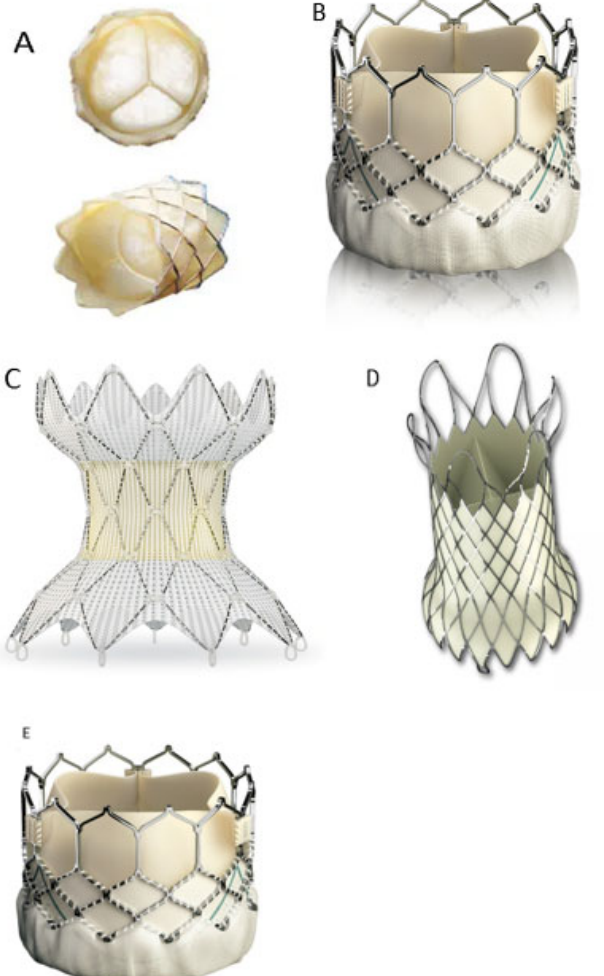
Figure 1. ( A ) Medtronic Melody Pulmonary valve, comprised of a bovine jugular vein valve sutured within a platinum iridium frame; with the permission of reproduction by Medtronic Inc. ( B ) Edwards SAPIEN 3 valve, made of bovine pericardial tissue attached to a balloon ‐ expandable, cobalt ‐ chromium frame for support; with the permission of reproduction by Edwards Lifesciences Inc. ( C ) Medtronic HARMONY Transcatheter Pulmonary Valve, comprised of porcine pericardial tissue valve and self ‐ expanding nitinol frame with polyester cloth covering; with the permission of reproduction by Medtronic Inc. ( D ) VenusP ‐ Valve, consisting of a self ‐ expanding stent made of nitinol with a tri ‐ leaflet porcine pericardial tissue; with the permission of reproduction by Venus Medtech Inc. ( E ) Edwards SAPIEN XT valve, made of bovine pericardial tissue with high radial strength cobalt ‐ chromium frame with low frame height design; with the permission of reproduction by Edwards Lifesciences Inc.